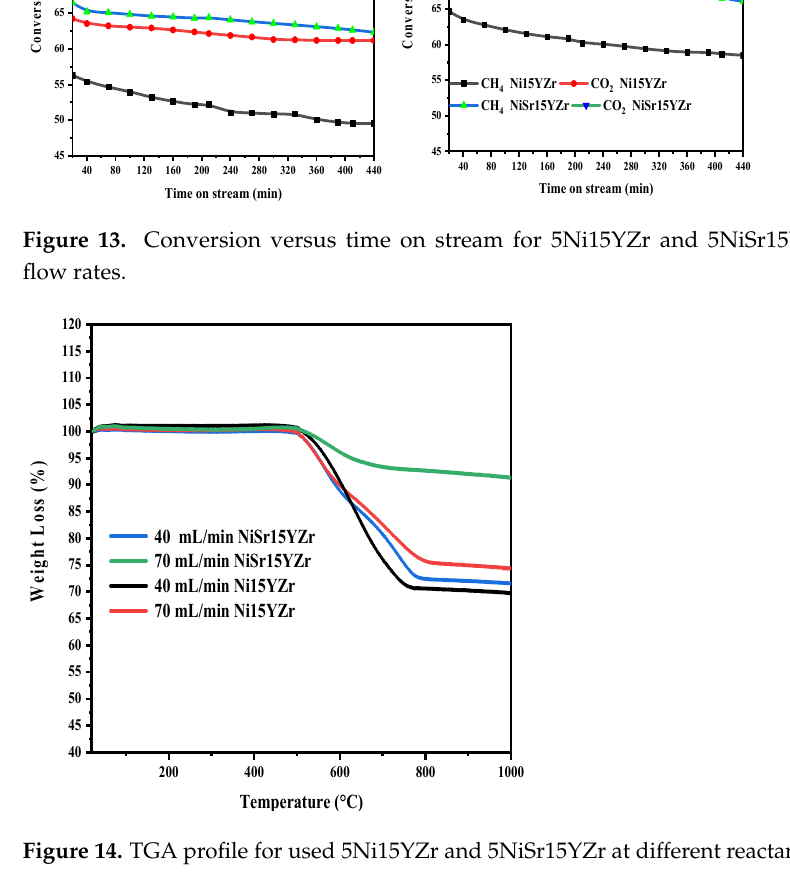
Figure 14. TGA profile for used 5Ni15YZr and 5NiSr15YZr at different reactant flow rates.